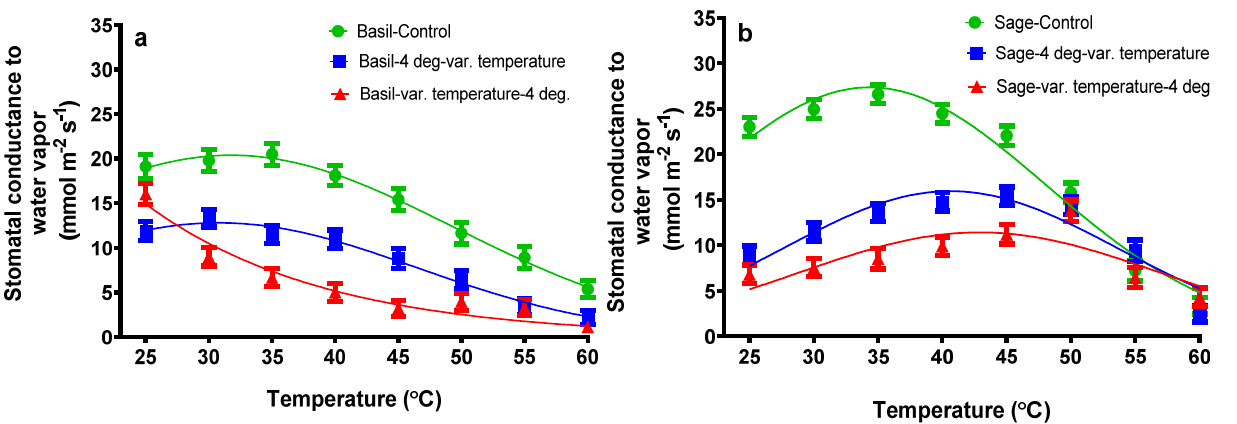
Figure 2. The stomatal conductance to water vapor from basil plants ( a ) and sage plants ( b ) subjected to different temperatures. The values are averages of three independent measurements.